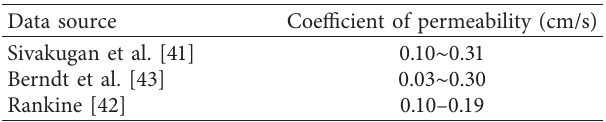
Table 4: Measured data of coefficient of permeability of concrete brick used for barricade.